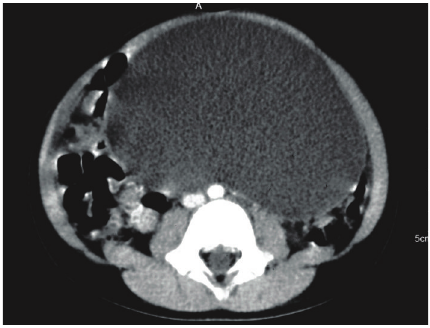
Figure 3: Abdominal CT showing a 13cm × 8 cm × 12 cm cystic abdominal mass.